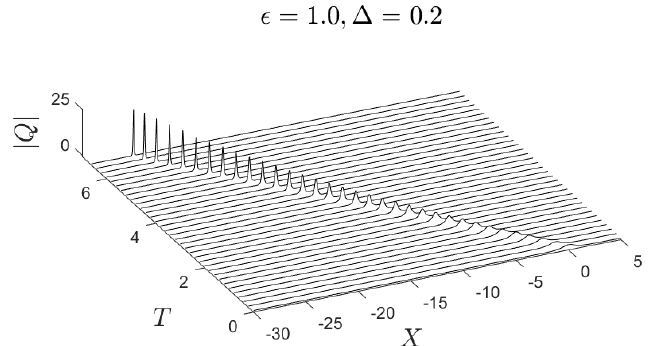
Figure 5. Case 2: Growing amplitude moving soliton from Equation (7) when (cid:101) = 1.0, M = 2, K = − 2, and ∆ = 0.2.